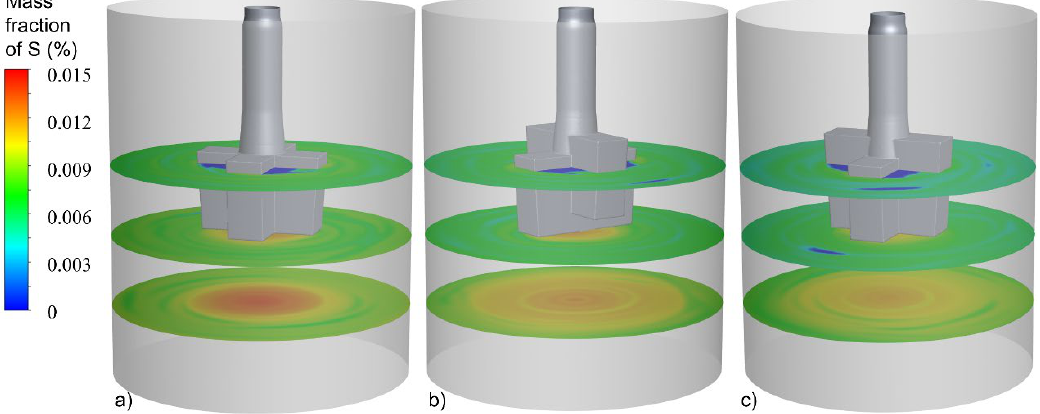
Figure 8. Sulfur concentration distribution at 600 s. ( a ) impeller model 1, ( b ) impeller model 2, ( c ) impeller model 3.